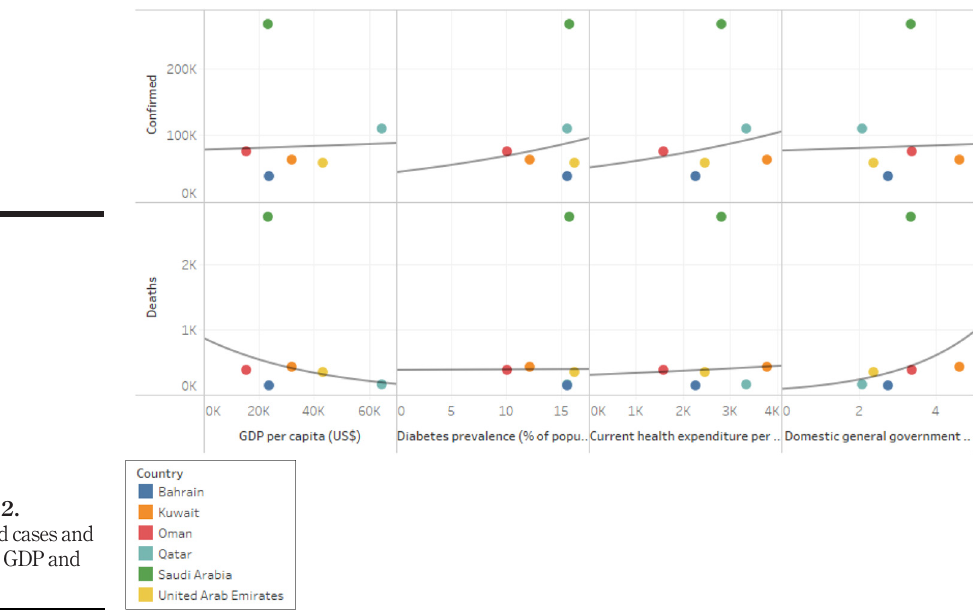
Figure 12. Con fi rmed cases and deaths vs GDP and health